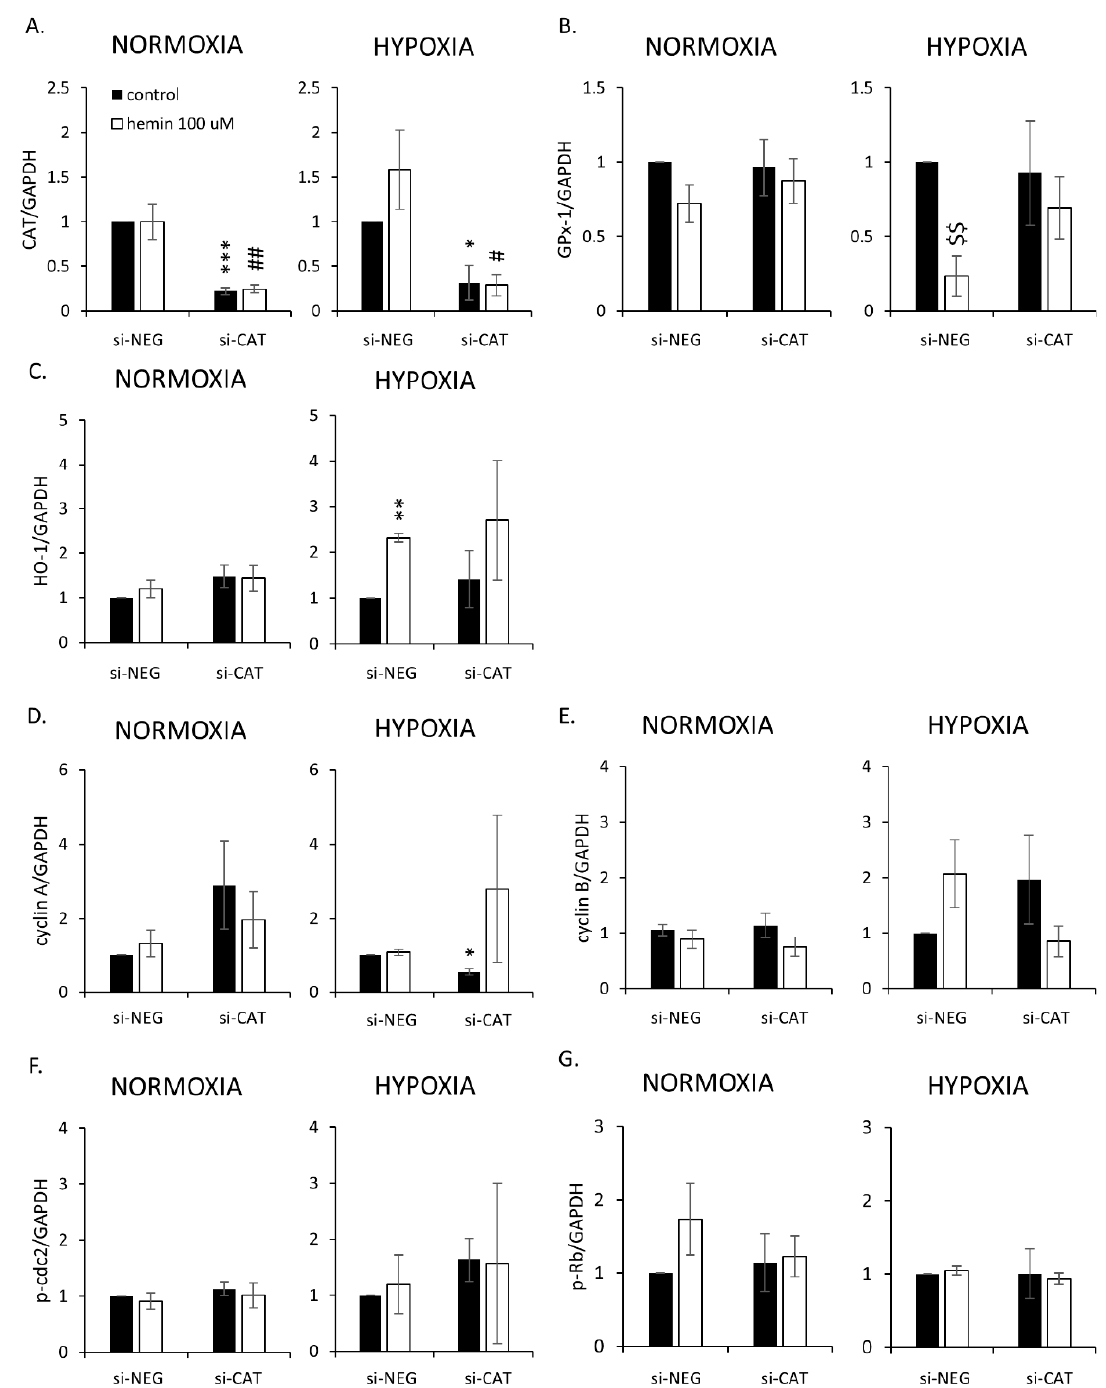
Figure A8. Evaluation of the protein expression in HCT116 cells, where gene encoding CAT was silenced with the use of siRNAs: antioxidative and proliferation markers. Cells were cultured in parallel in normoxia or hypoxia. Cells were treated with 2.5 µM IRINO and exposed to 100 µM hemin. Control cells were subjected to IRINO and NaOH. Quantification is based on the densitometry analysis performed with the use of ImageJ software. Data are shown as the ratio of the protein amount to respective protein loading control (GAPDH): ( A ) CAT; ( B ) GPx-1; ( C ) HO-1; ( D ) cyclin A; ( E ) cyclin B; ( F ) p-cdc2; ( G ) p-Rb. Each bar represents mean ± SEM, n ≥ 3; * p < 0.05, ** p < 0.01, *** p < 0.001—siNEG control vs. siCAT control; # p < 0.05, ## p < 0.01—siNEG hemin 100 µM vs. siCAT hemin 100 µM; $$ p < 0.01—control vs. hemin 100 µM.